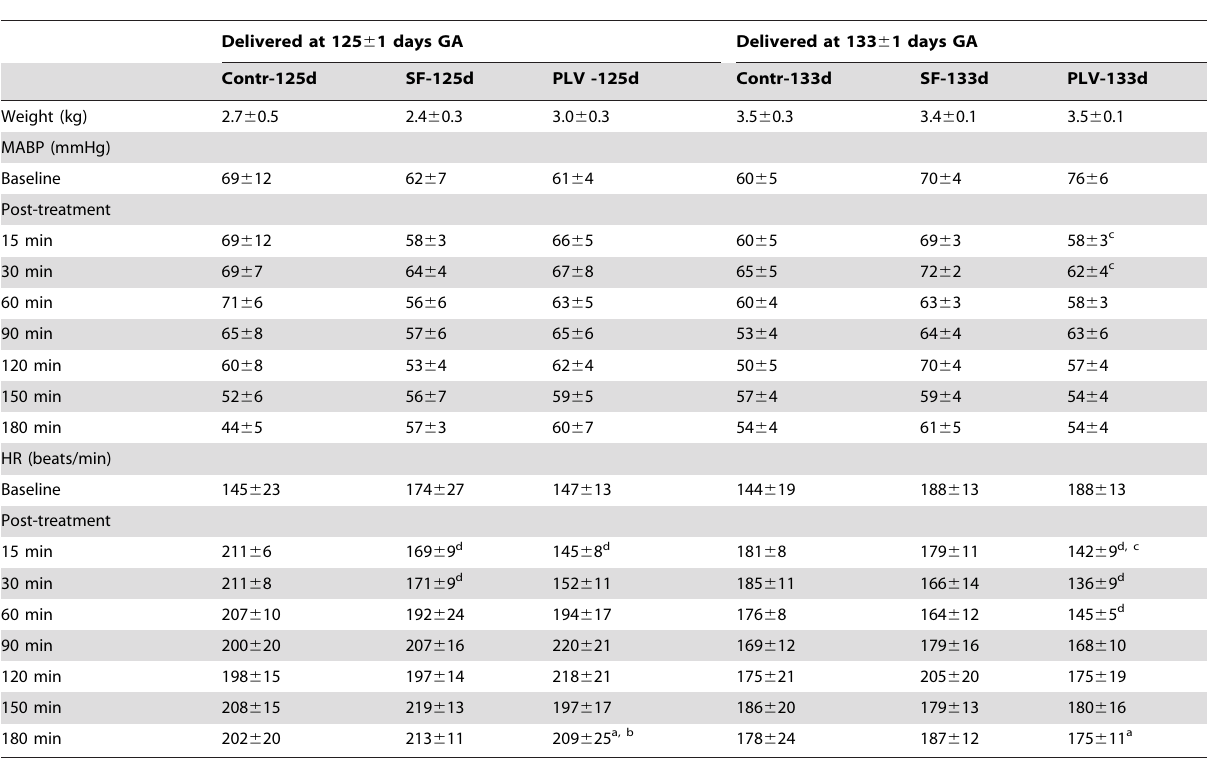
Table 2. Hemodynamic parameters in preterm lambs at two gestational